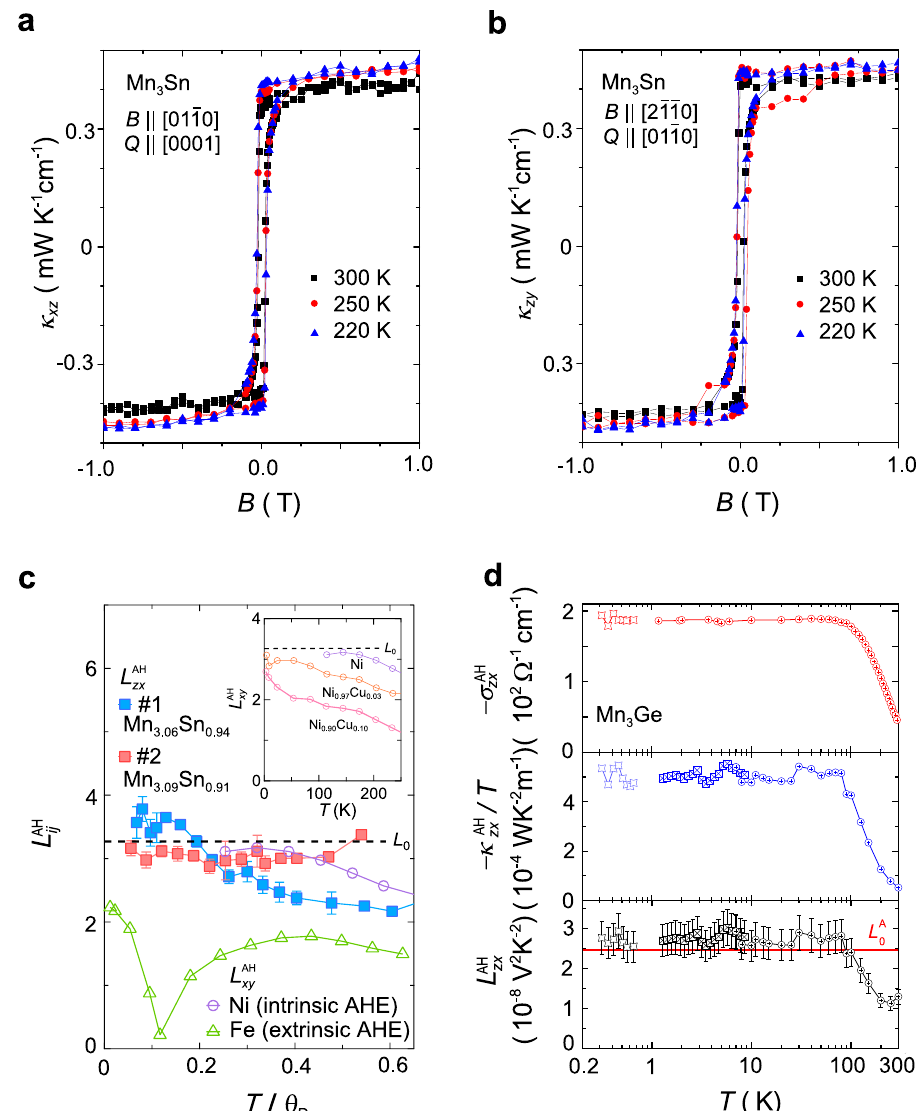
Fig. 3 Anomalous transverse Wiedemann – Franz (WF) law found in Mn 3 X ( X = Sn, Ge). a , b Field dependence of the thermal Hall conductivity κ xz ( a ) and κ zy ( b ). c Temperature dependence of the anomalous Lorentz number L AH ¼ ð e = k Þ 2 T κ AH = σ AH fi lled blue squares) and Mn fi lled B zx zx zx for Mn 3.06 Sn 0.94 ( 3.09 Sn 0.91 ( red squared). The horizontal axis indicates the temperature normalized by the Debye temperature, θ D . The θ D of the two samples is about 300 K. The dashed line marks L 0 ¼ π 2 . The L AH xy of conventional ferromagnetic metals Ni with θ D ≈ 450 K (open purple circles) and Fe with θ D ≈ 470 K (open green 3 triangles) are also included for comparison 67,68 . Inset: temperature dependence of L AH xy observed in Ni and NiCu alloys 68 . The de fi nition of L AH zx and L 0 here is different from that in Eq. (3). d Temperature dependence of the anomalous Hall conductivity, (cid:2) σ AH zx (top), the anomalous thermal Hall conductivity divided by temperature, (cid:2) κ AH zx = T (middle), and the anomalous Lorenz number, L AH zx ¼ T κ AH zx = σ AH zx (bottom) for Mn 3 Ge. This panel is replotted with data extracted from ref. 13 . Adapted from ref. 19 , APS ( a , b ), ref. 66 ( c ), and ref. 13 , AAAS ( d